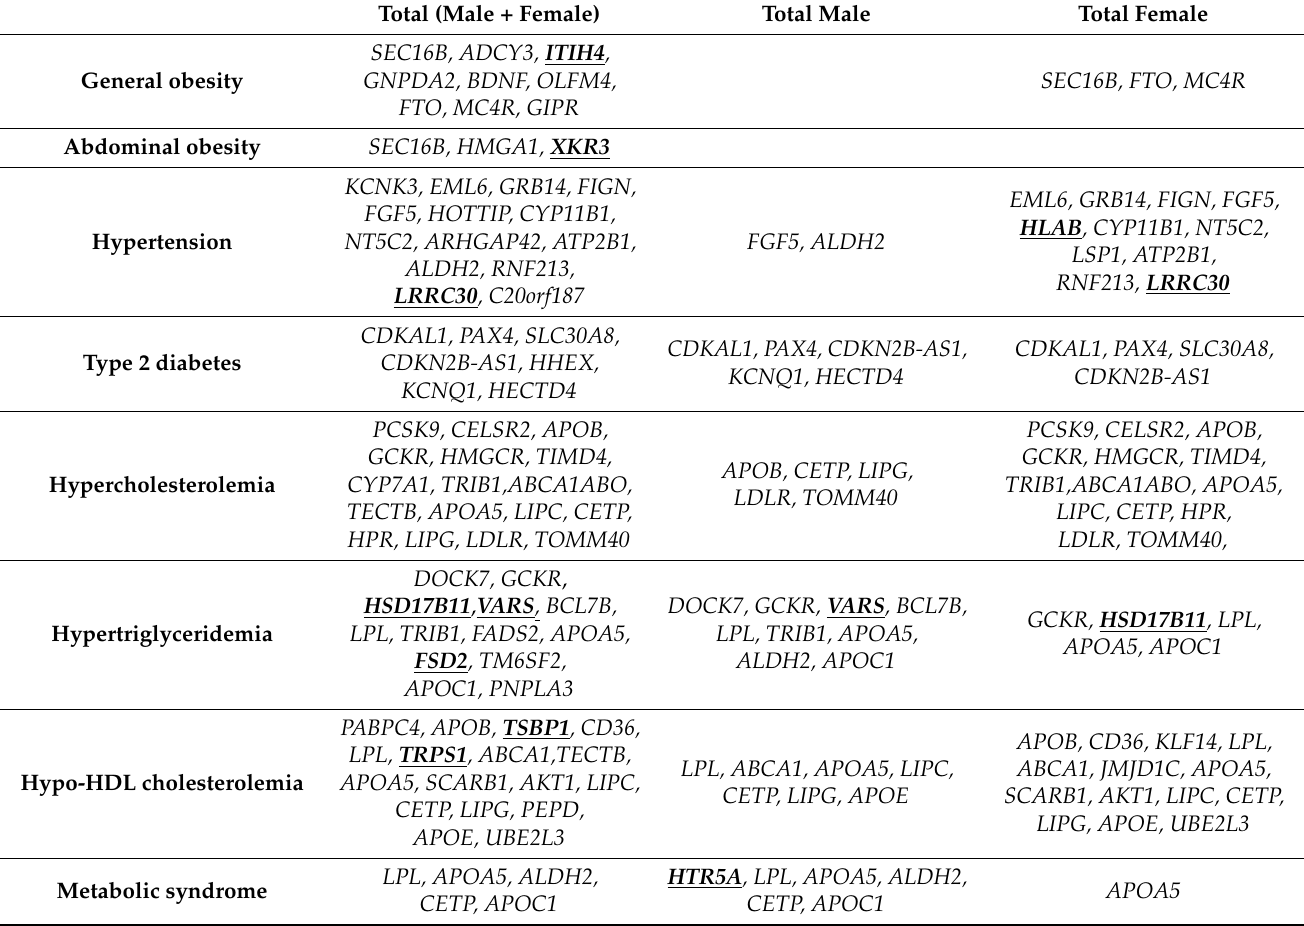
Table 2. The significant genetic risk factors according to sex and each metabolic disorder.